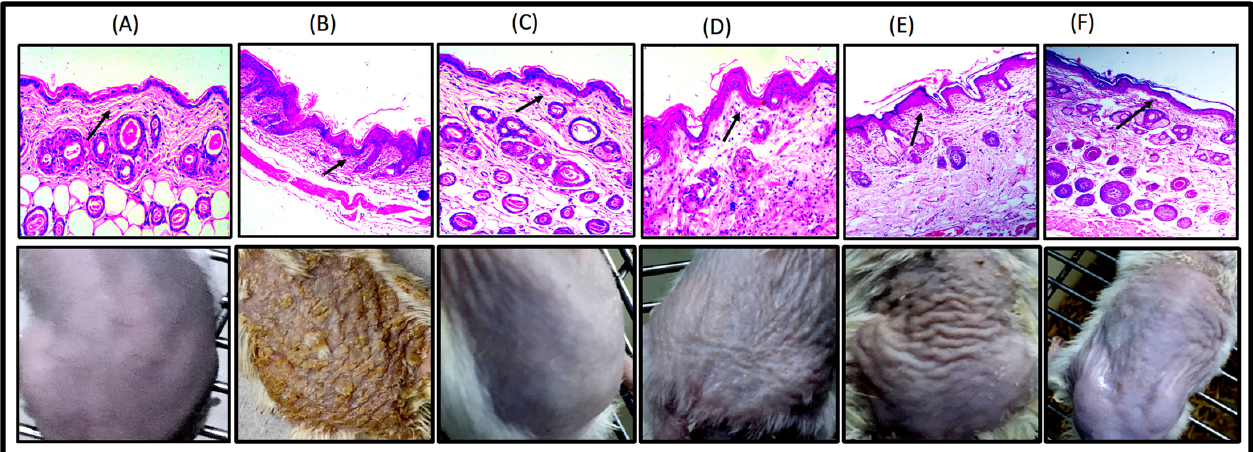
Figure 6 . Antipsoriatic experiment in vivo results. Sample picture of balb/c mice from each experi- mental group: ( A ) Control group, ( B ) Negative control, ( C ) FTQ-NEG, ( D ) Positive control group, ( E ) Free drug, and ( F ) FA loaded in a gel, along with H&E images of histopathological sections from all research groups. Psoriatic plaques in the histological sections are represented with the black ar- rows.